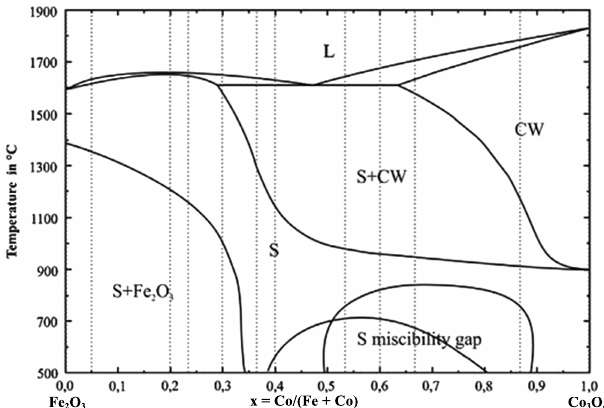
Fig. 2. Phase diagram of the Co–Fe–O system with material compositions (dotted lines) (S: spinel, CW: cobalt-wüstite, L: liquid)